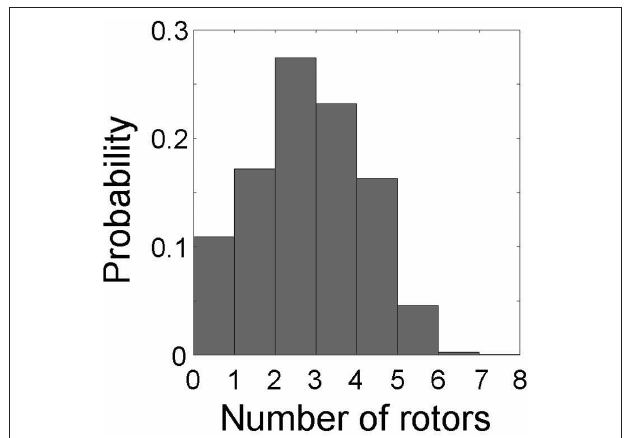
FIGURE 8 | Probability distribution of the number of rotors. The number of rotors ranges from 0 to 7 in 1,000 data